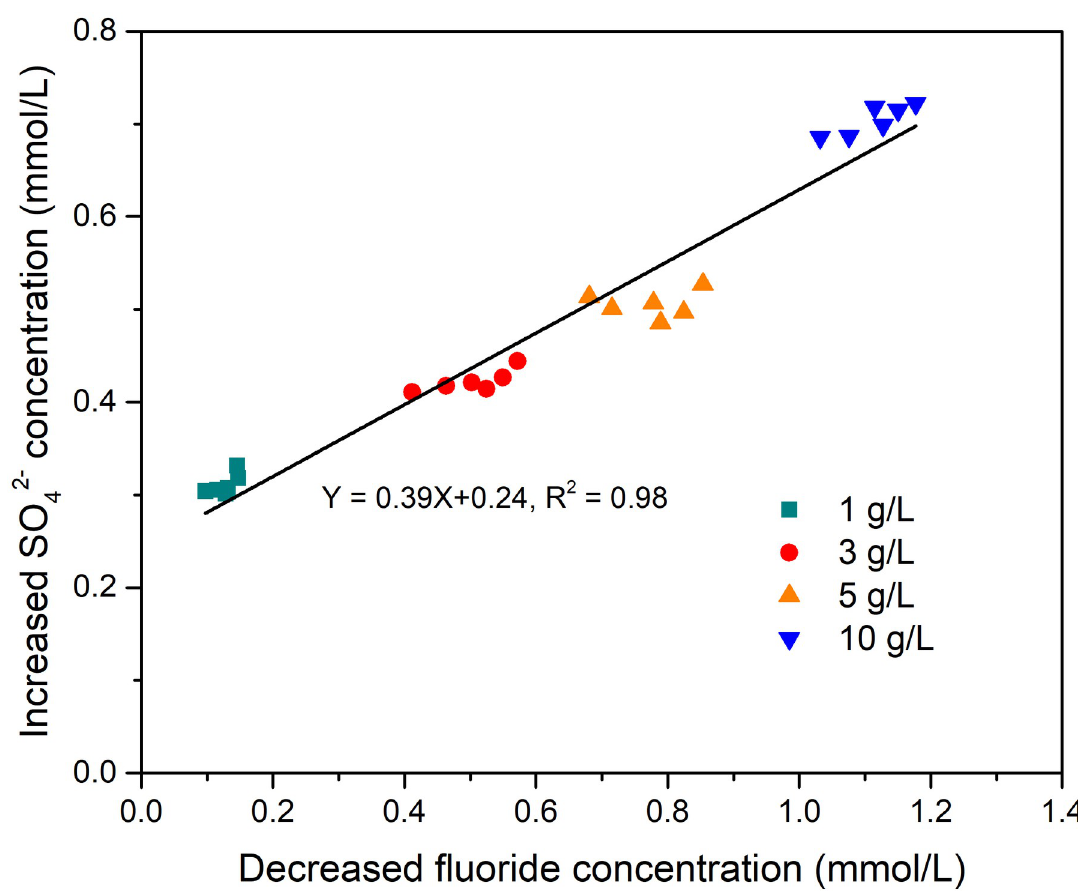
Fig 4. Relationship between decreased fluoride concentration and increased SO 42- concentration in solution at different proportions of metaettringite.